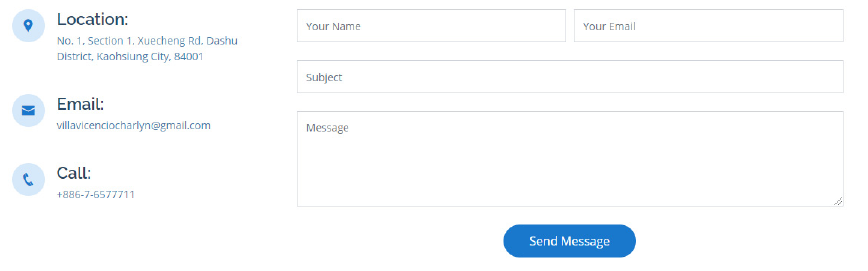
Figure 14. The contact form of the website.